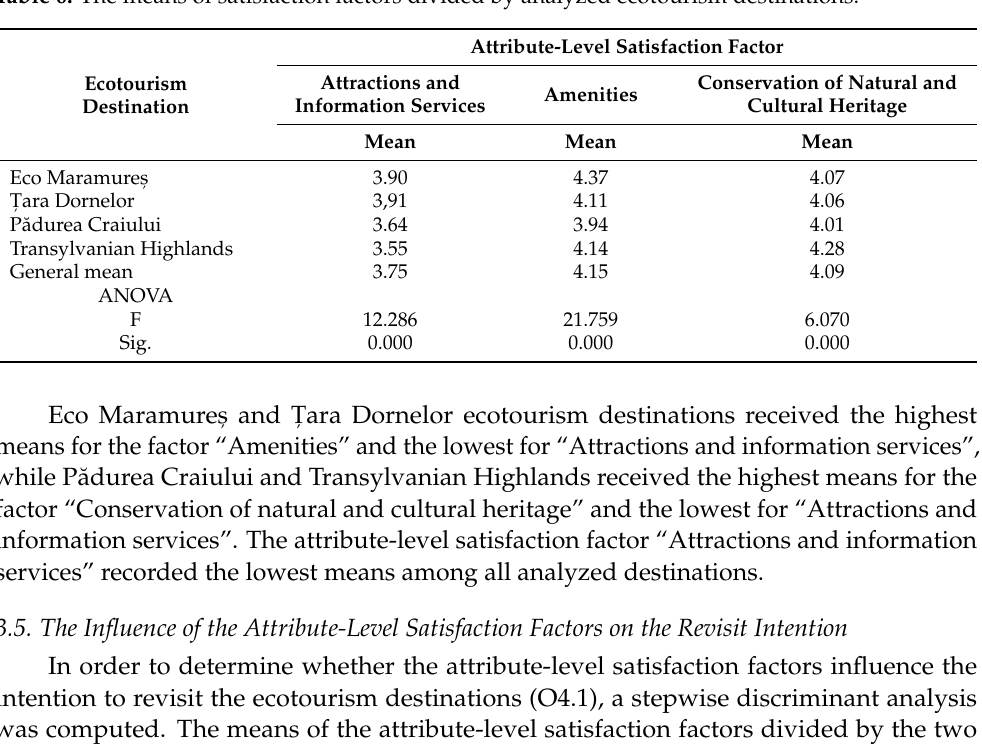
Table 6. The means of satisfaction factors divided by analyzed ecotourism destinations.